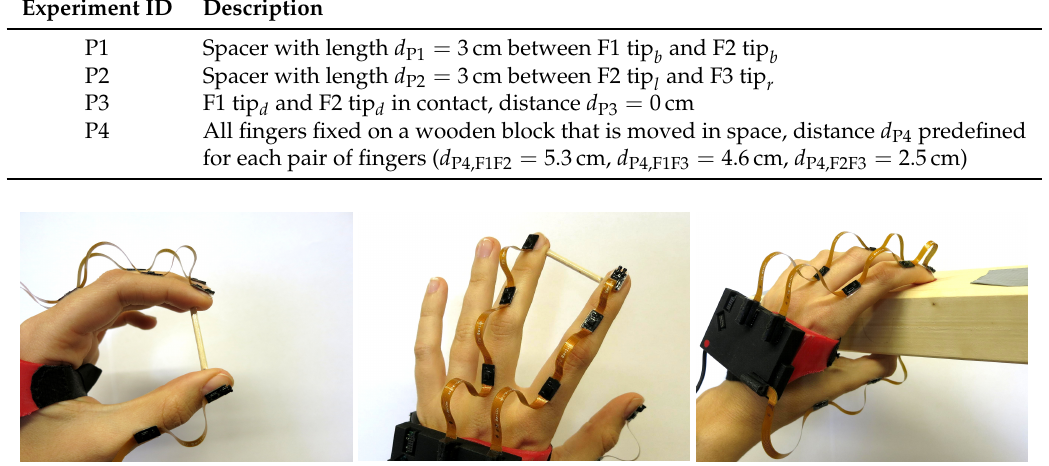
Figure 11. Experimental setup for the evaluation under realistic conditions. The images display the hand poses with the spacer and wooden block.